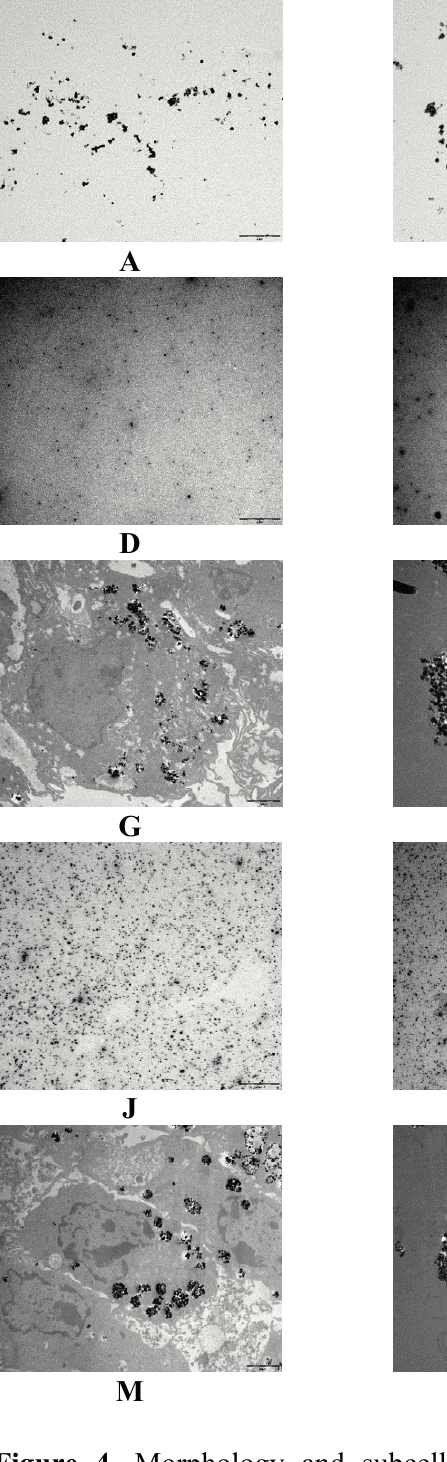
Figure 4. Morphology and subcellular localization of surface-modified nanoparticles (SMNPs), iron oxide nanoparticles (IONPs), and iron citrate in bone marrow cells. SMNPs ( A ); IONPs ( B ); control bone marrow cells ( C ); cell supernatant with 1% SMNPs ( D ); cell supernatant with 1% IONPs ( E ); cell supernatant with 1% iron citrate ( F ); cell pellet with 1% SMNPs ( G ); cell pellet with 1% IONPs ( H ); cell pellet with 1% iron citrate ( I ); cell supernatant with 10% SMNPs ( J ); cell supernatant with 10% IONPs ( K ); cell supernatant with 10% iron citrate ( L ); cell pellet with 10% SMNPs ( M ); cell pellet with 10% IONPs ( N ); and cell pellet with 10% iron citrate ( O ). Scale bars in the images indicate 2 μ